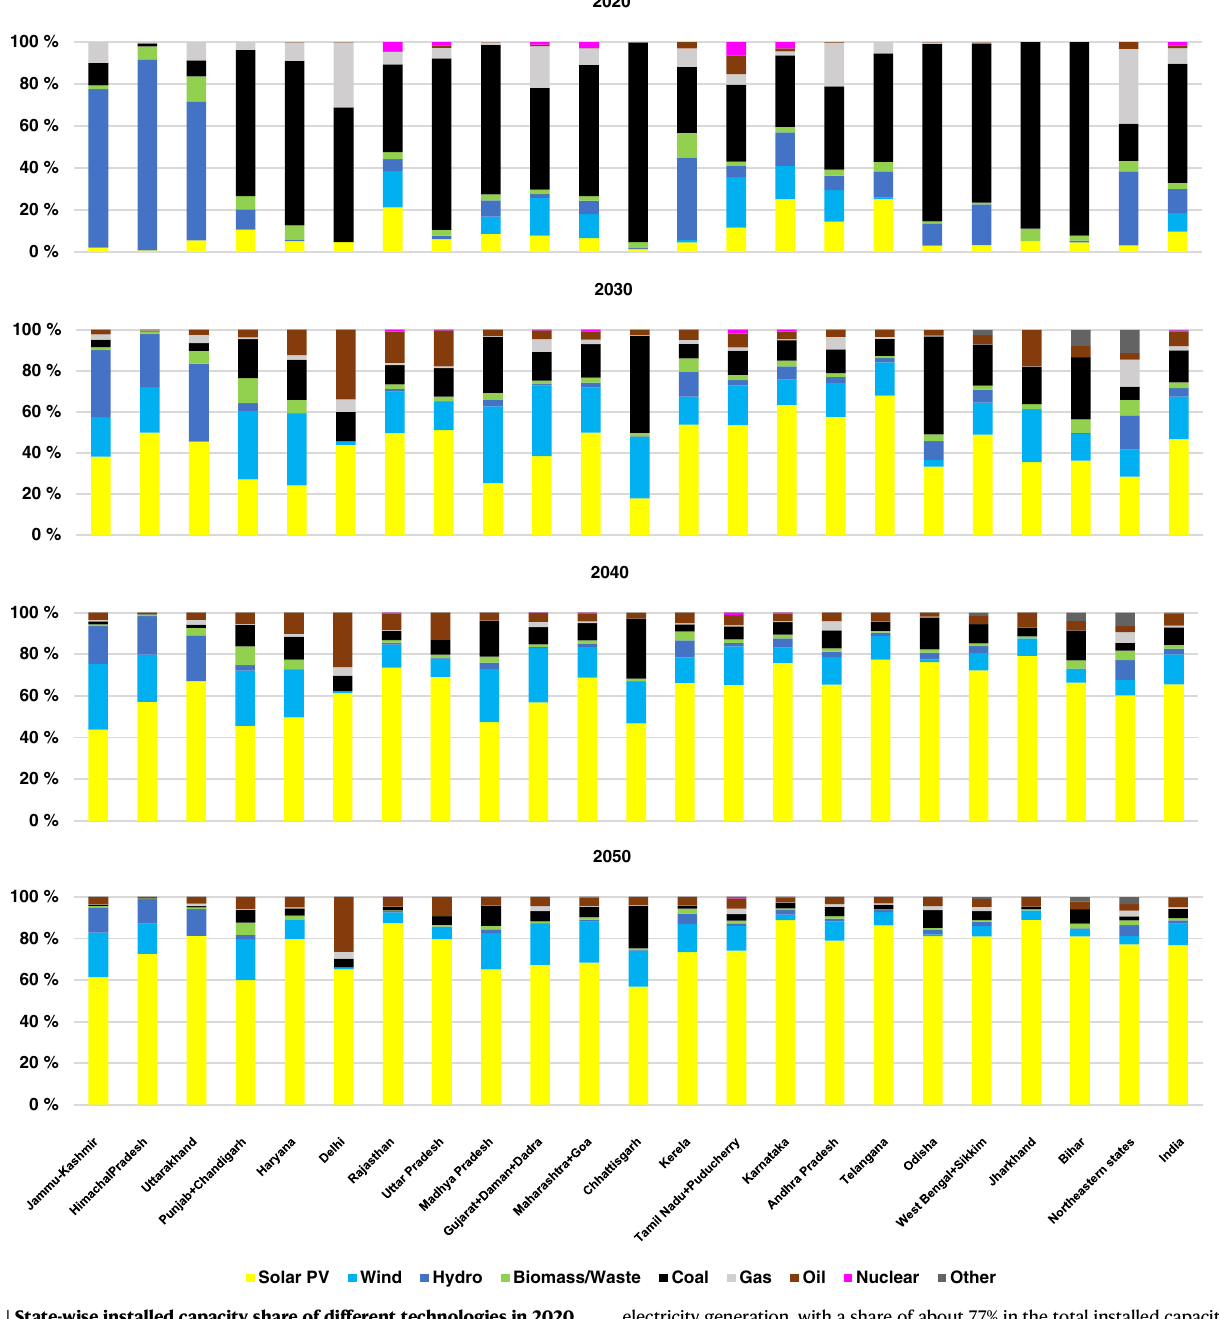
electricity generation, with a share of about 77% in the total installed capacity across India in